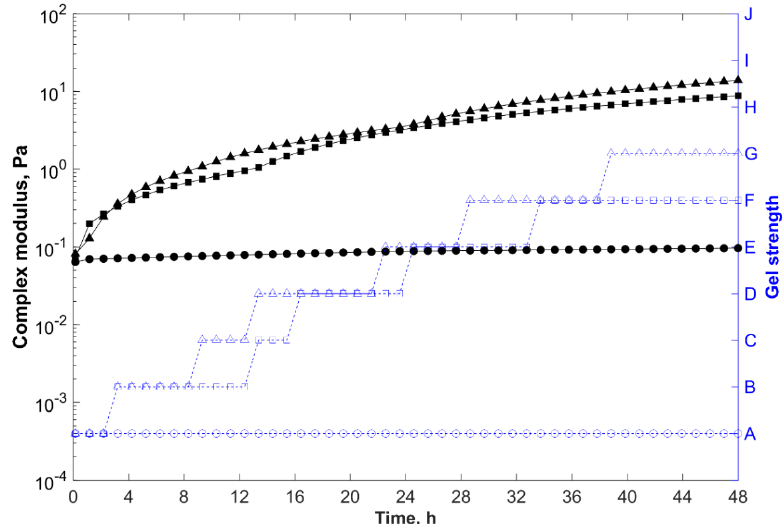
Figure 3. Complex modulus ( ─ ) and gel strength (- -) versus time for samples prepared in field water at 85 °C, with 0.8 wt % of clay, 0.5 wt % of PEI, and different polymer concentrations. Figure 4. Complex modulus ( ─ ) and gel strength (- -) versus time for samples prepared in field water at 85 °C, with 0.6 wt % polymer, 0.8 wt % clay, and different PEI concentrations.